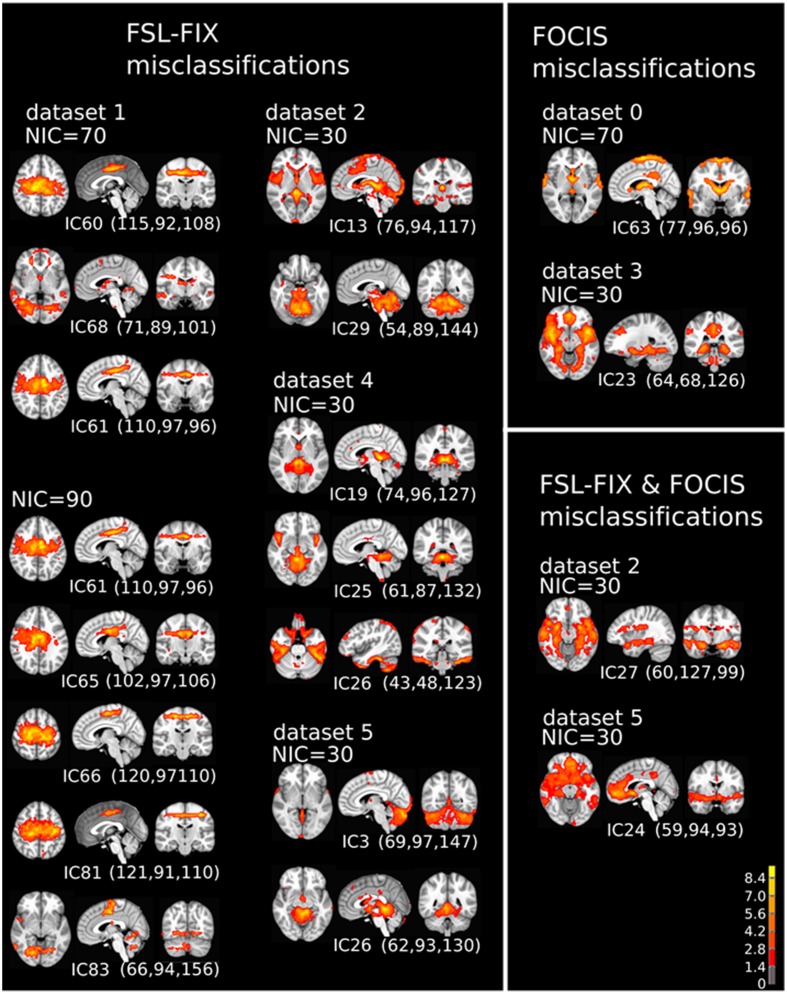
The spatial patterns of all misclassified ICs summarized in Table 4.